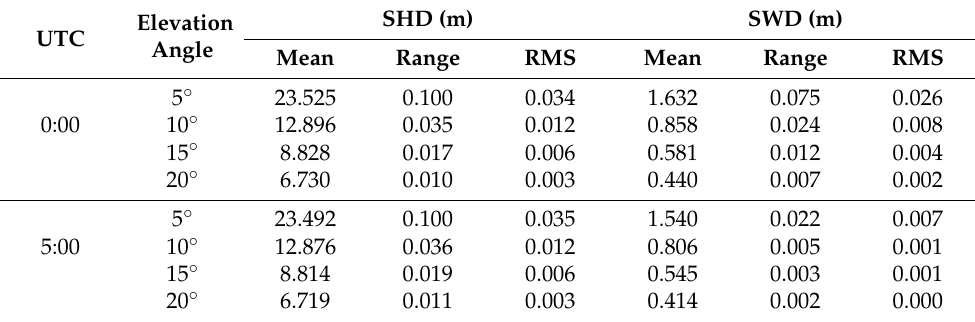
Table 4. Representative ray-tracing slant delays for SHAO located in Shanghai on 26 December 2018.